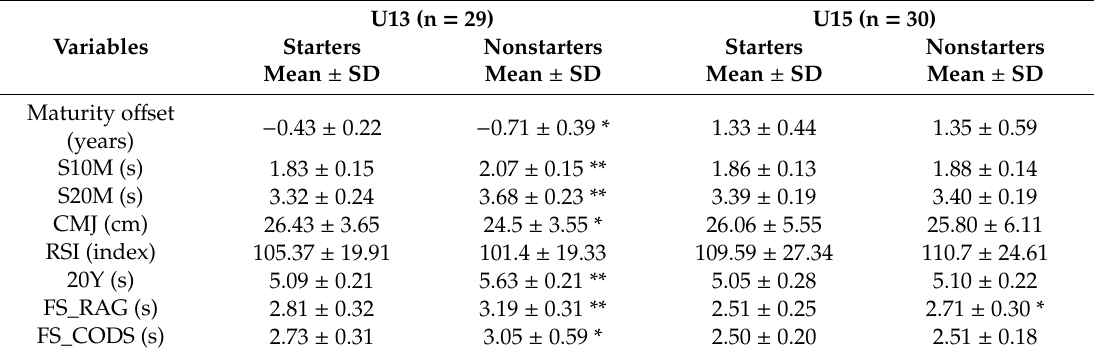
Table 3. Descriptive statistics and differences between performance groups in each age category derived by independent sample t-test.